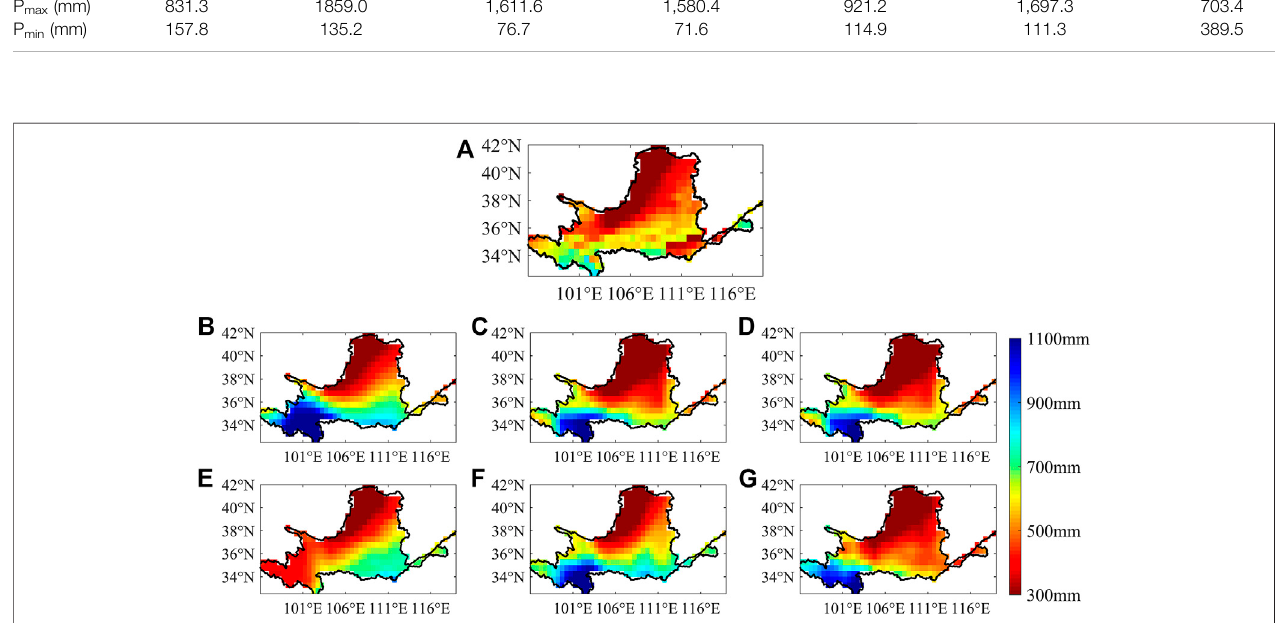
FIGURE 8| Spatial distribution ofaverage annual precipitation from the observation and six higher-scoring GCMs. Panels (A – G) are the observed data, ACCESS- CM2, CNRM-CM6 -1, CNRM-ESM2-1, FGOALS-f3-L, MPI-ESM1-2-HR, MRI-ESM2-0, respectively.